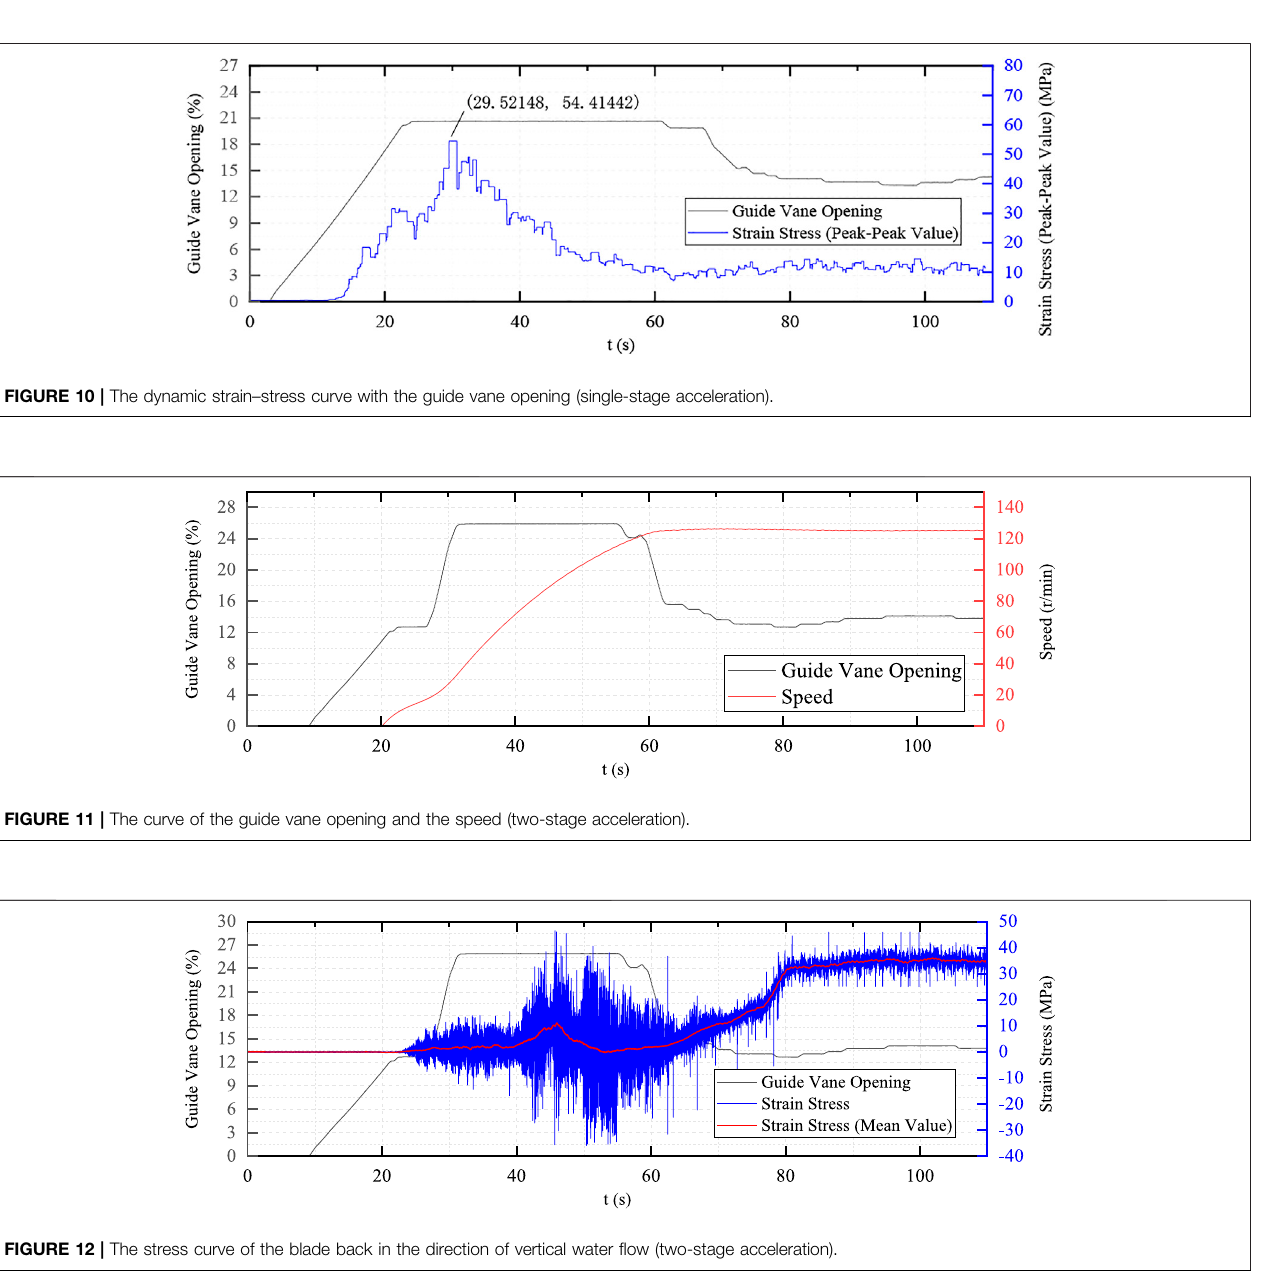
Frontiers in Energy Research |